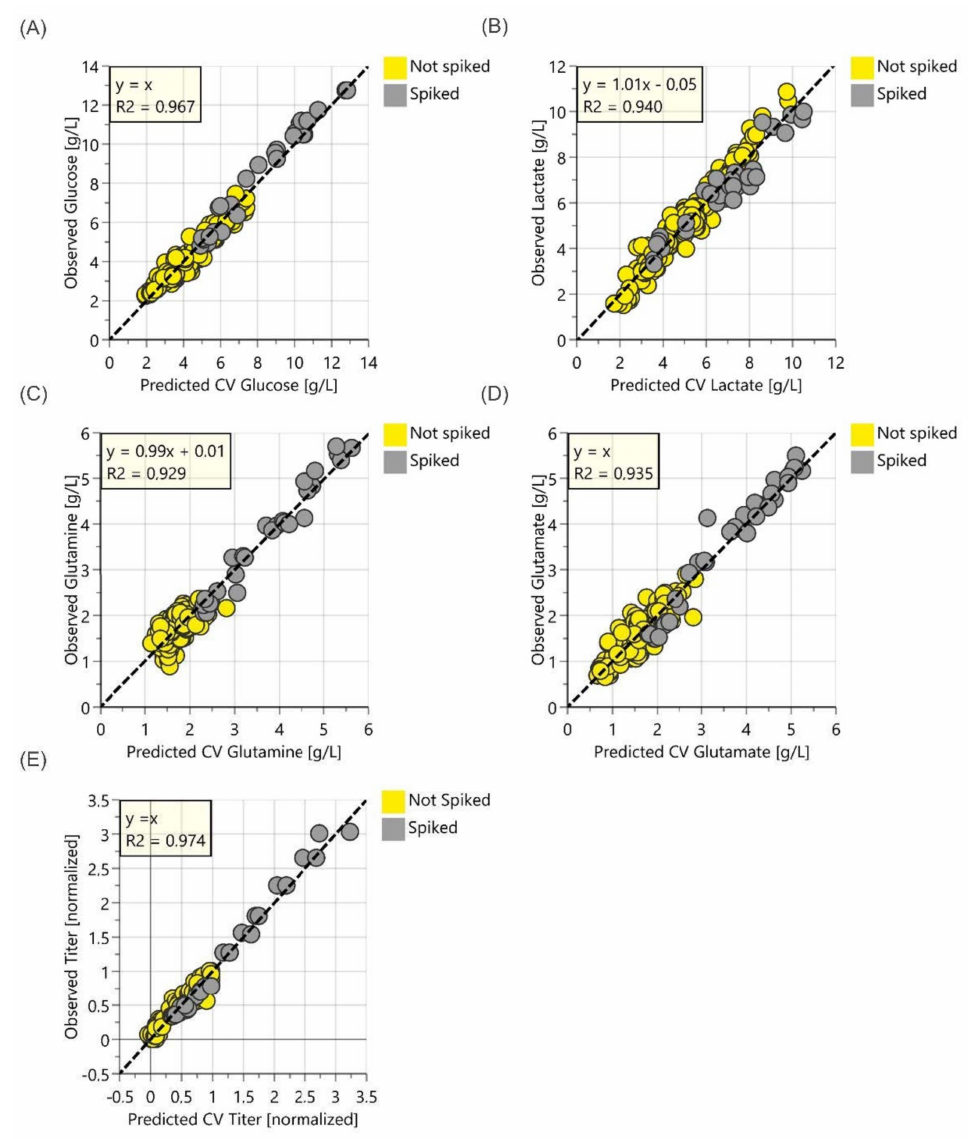
Figure 4. Parity plots of the observed values vs. predicted values from cross-validation for OPLS models, including spiked cell culture samples for ( A ) glucose, ( B ) lactate, ( C ) glutamine, ( D ) glutamate and ( E ) normalized titer with spiked cell culture samples from the 250 mL mini